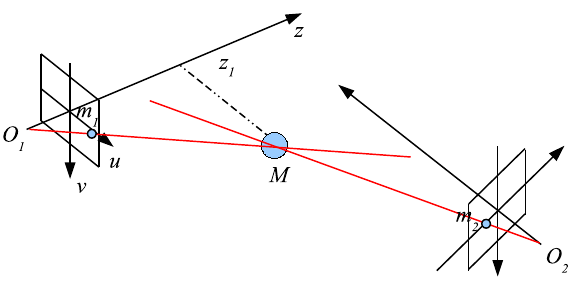
Figure 2: Smartphone used to test the reconstruction system: Huawei U8650 Sonic.